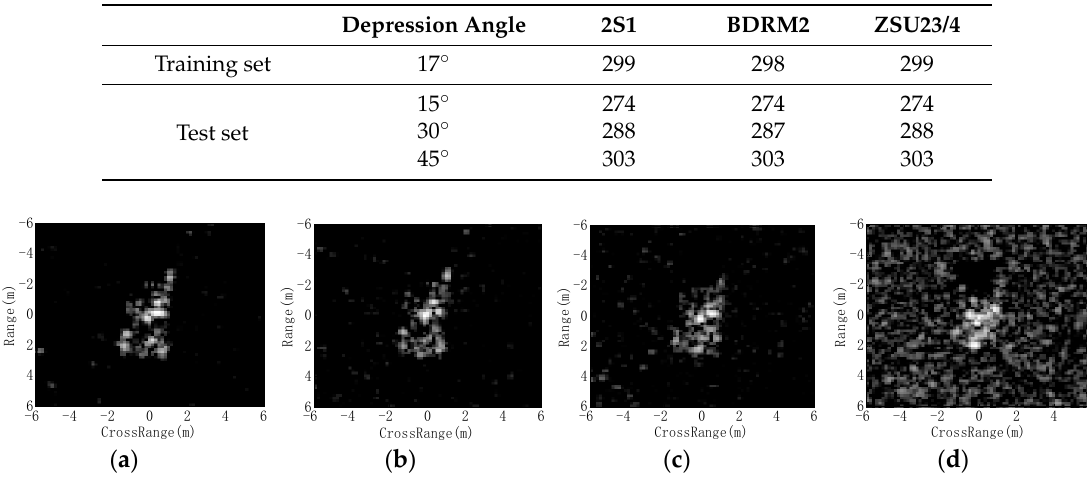
Figure 8. SAR images of 2S1 at different depression angles: ( a ) 15°; ( b ) 17°; ( c ) 30°; and ( d ) 45°. Table 8. Recognition results of the proposed method under depression variance.